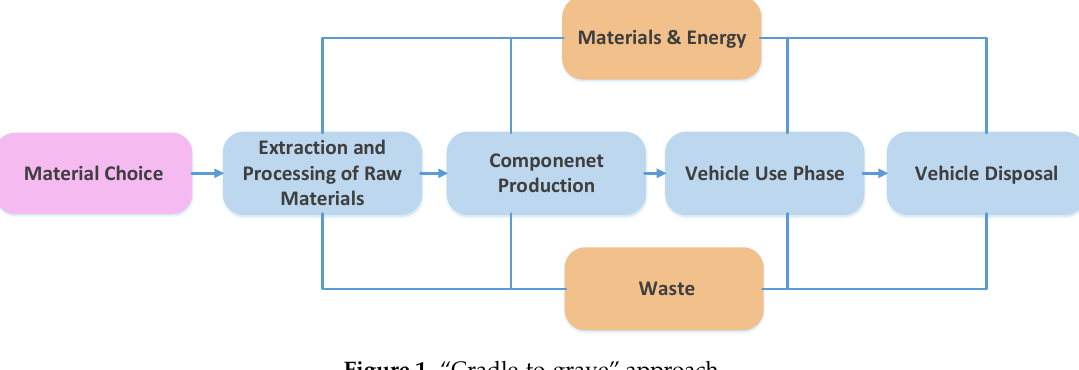
Figure 1. “Cradle-to-grave” approach.